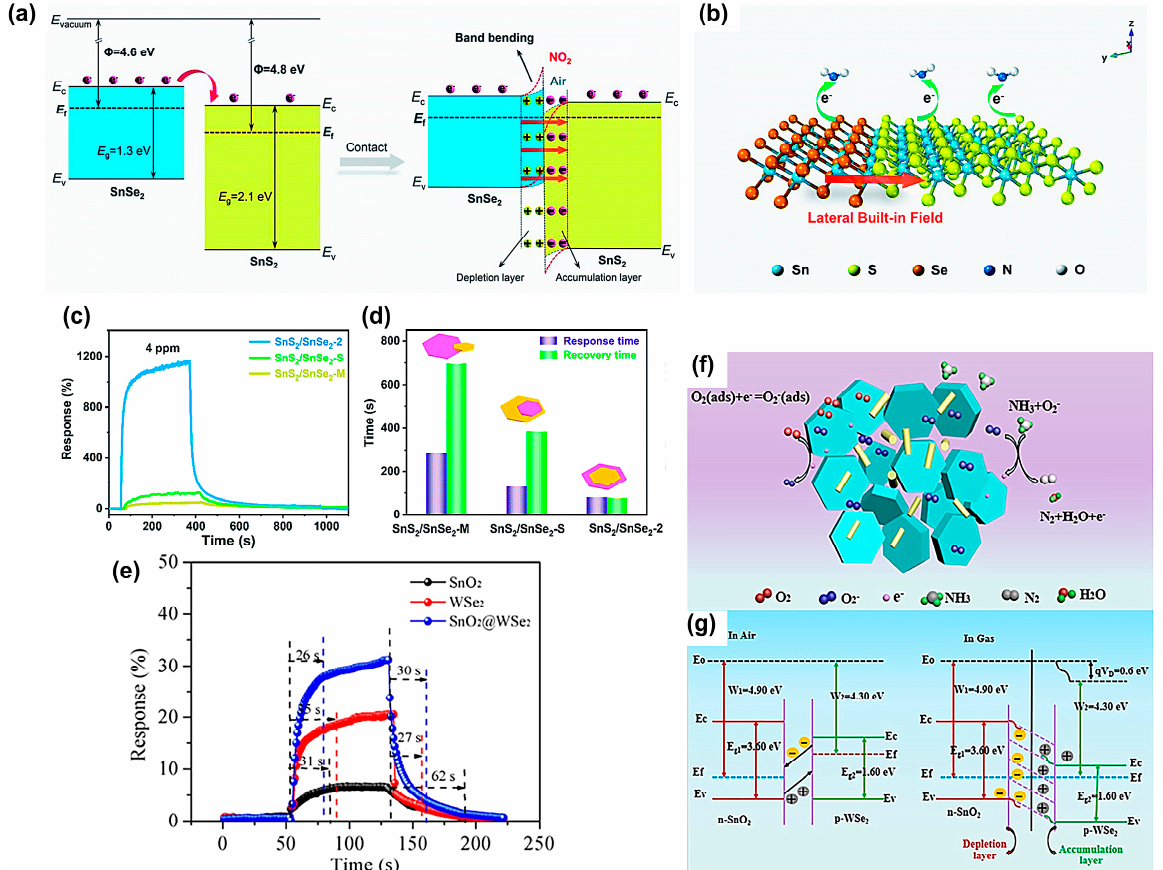
Figure 10. Schematic illustrations of ( a ) energy band structure and ( b ) NO 2 adsorption for the 2D/2D SnS 2 /SnSe 2 -2 heterostructure. ( c ) Response and ( d ) response and recovery times of SnS 2 /SnSe 2 – M, SnS 2 /SnSe 2 –S, and SnS 2 /SnSe 2 -2 heterostructures toward 4 ppm NO 2 at room temperature. Reprinted with permission from Ref. [108]. Copyright 2022, The Royal Society of Chemistry. ( e ) Re- sponse/recovery time of SnO 2 /WSe 2 , WSe 2, and SnO 2 sensors upon exposure to 1 ppm NH 3 . ( f ) Energy-band structure of the SnO 2 /WSe 2 sensor in air and NH 3 gas (Ec, Eg, Ev, and Ef are the bottom of the conduction band, band gap, top of the valence band, and the fermi-energy level). ( g ) Il- lustration of NH 3 sensing mechanism for SnO 2 /WSe 2 nanocomposite. Reprinted with permission from Ref. [111]. Copyright 2022,